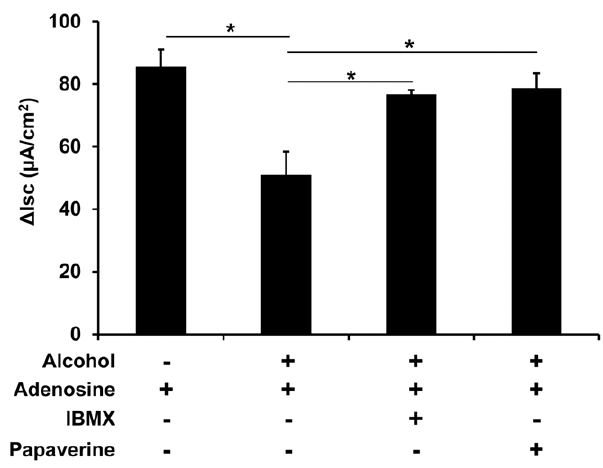
Figure 6. Phosphodiesterase inhibitors restore the ethanol suppression of adenosine-induced transepithelial chloride conductance. The air-liquid interface cultures of Calu-3 cells were exposed to 0 and 100 mM of ethanol for 24 hours. Adenosine- stimulated I SC was measured, showing that ethanol-exposed Calu-3 epithelia had significantly lower adenosine-stimulated I SC than the no ethanol control. However, phosphodiesterase inhibitors, IBMX (100 m M) or papaverine (50 m M), fully restored the ethanol-suppressed adeno- sine-stimulated I SC . Asterisks indicate statistically significant differences between groups (p , 0.05, n=4 for each